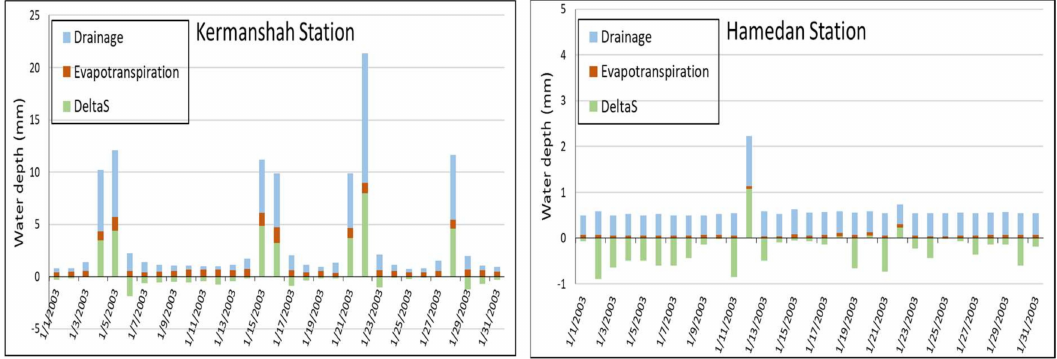
Figure 6. Contributions of the different components of the water balance equation to SM2R-AMSRE at Kermanshah station for January 2003 (left) and Hamedan station for July 2004